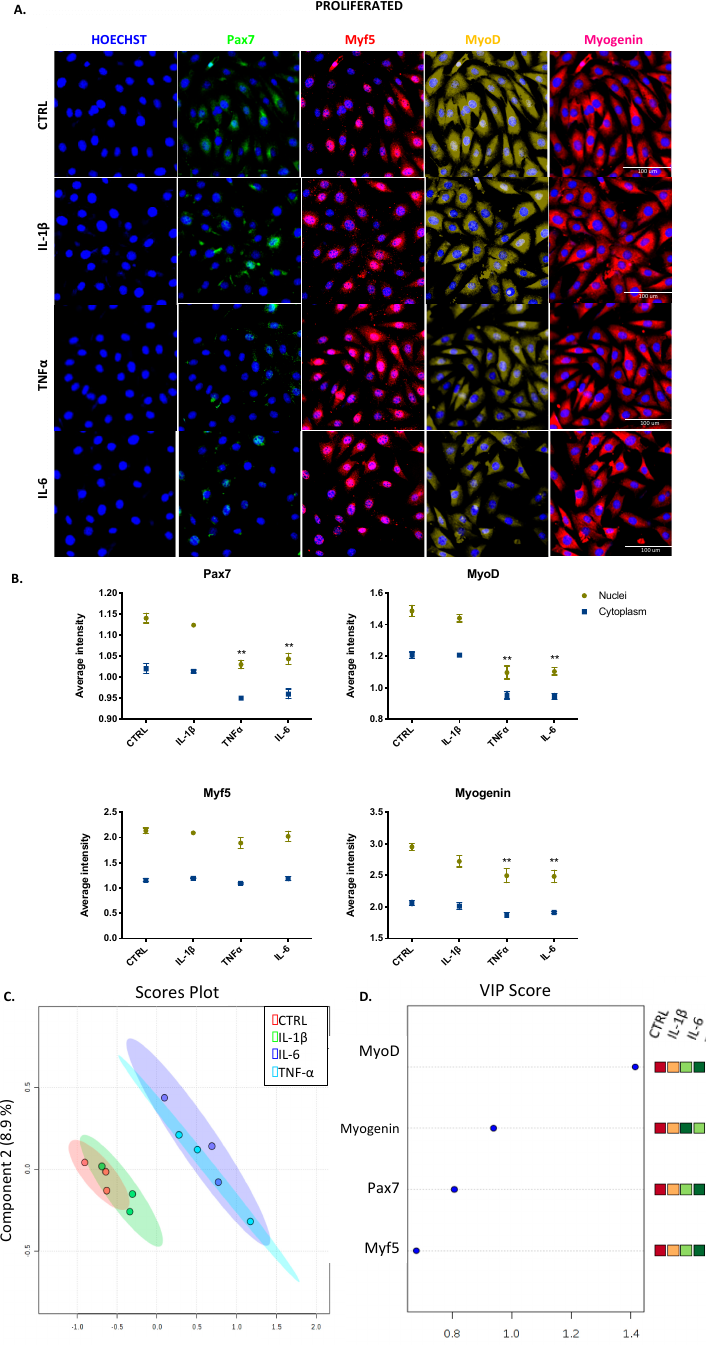
Figure 4. Transcription factor expression for C2C12 cells at the proliferative stage. ( A ) Representative images of myogenic transcription factor expression obtained by high content screening (HCS) (scale bar: 100 μ M). ( B ) The average intensity in the nucleus (yellow) and cytoplasm (blue) of every factor at basal (CTRL) and treated conditions. ( C ) PCA and PL-SDA score plots show the differences and similarities between treatments IL-1 β (green), IL-6 (blue), and TNF- α (light blue) and the control (red). ( D ) Variable importance in projection (VIP) score indicates that MyoD is the most relevant factor at this stage. Data are shown as mean ± SEM (** p < 0.01 vs. control from two-way ANOVA and Dunnett’s post-test; principal component analysis (PCA) and partial least squares discriminant analysis